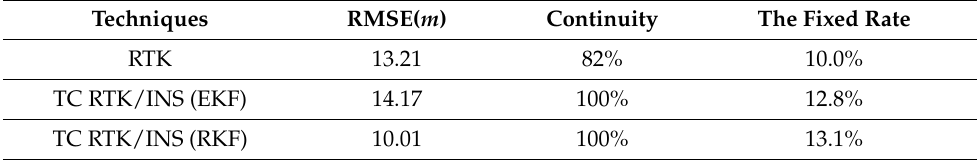
Table 5. The positioning performance comparison